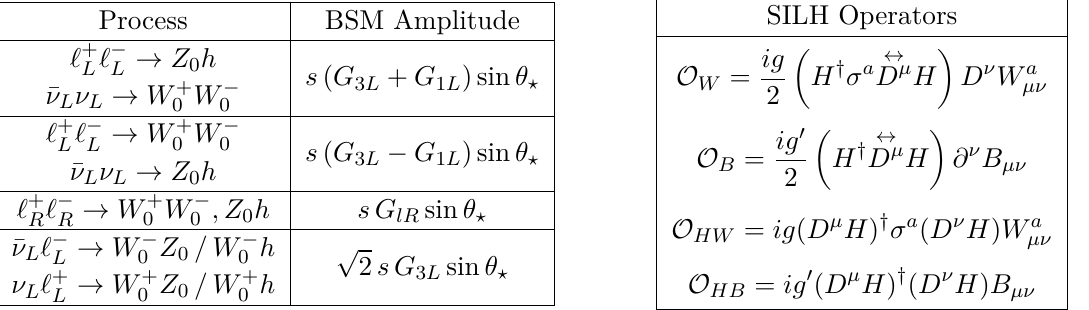
√ s and θ ? . Right: the relevant SILH